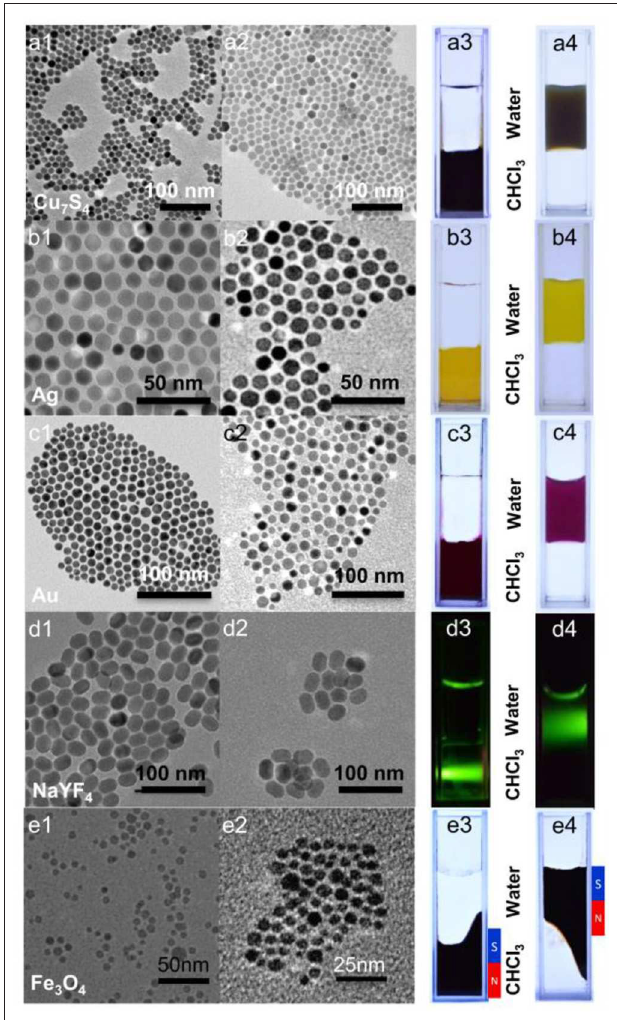
FIGURE 2 | TEM images (a1–e1, a2–e2) and photographs (a3–e3, a4–e4) of various types of inorganic nanocrystals (a) : Cu 7 S 4 , (b) : Ag NPs, (c) : Au NPs, (d) : NaYF 4 :Yb 3 + /Er 3 + , and (e) Fe 3 O 4 before (1, 3) and after (2, 4) surface engineering. Photograph 3 and 4: the top layer is water and the bottom layer is chloroform; (a–c) daylight; (d) 980-nm diode laser; (e) daylight with magnet.